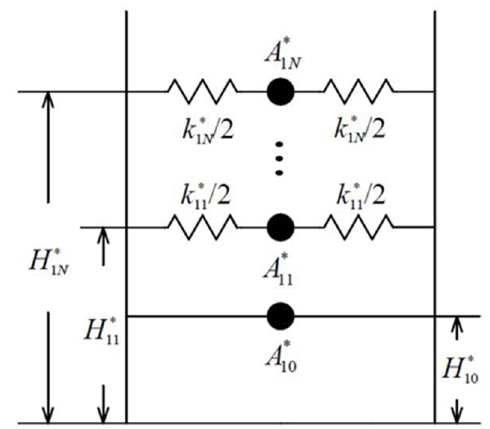
Figure 3. Equivalent analytical model for liquid sloshing.